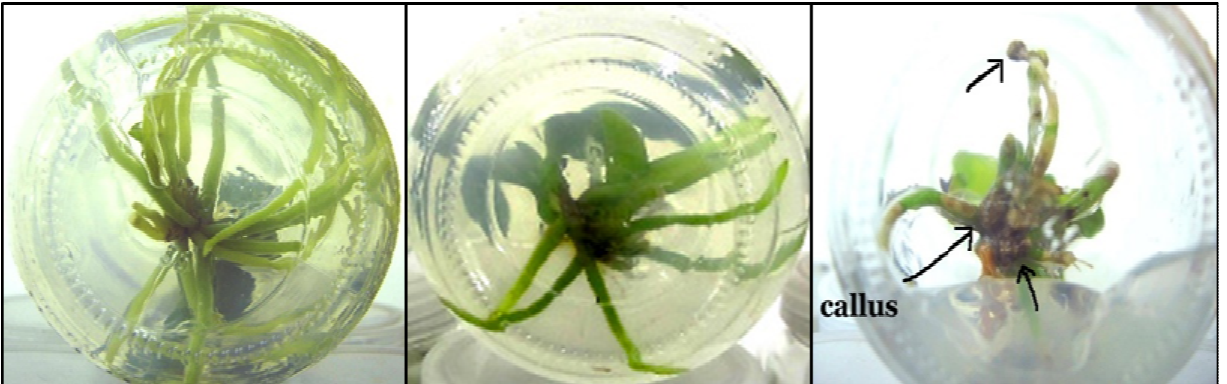
Fig. 3. In vitro inhibitory impact of increasing NAA and IBA from 0.1/0.1 and 1.0/1.0 mg l -1 to 3.0/ 3.0 mg l -1 , jars from left to